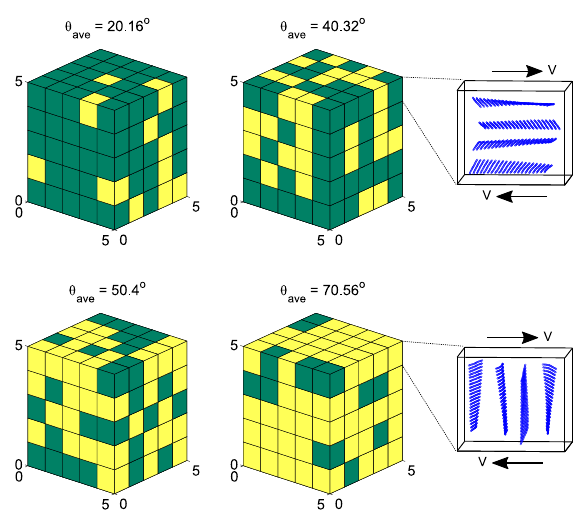
Figure 18. Examples of construction of a large cell for the upper scale simulation benefitting from a random mixing of unit cells resulting in various average initial orientation angles, θ ave . The initial configurations of the unit cells before the flow starts are also given. Reprinted from Gooneie et al. [196]. Copyright 2016, with permission from John Wiley & Sons Inc. Polymers 2017 , 9 , 16